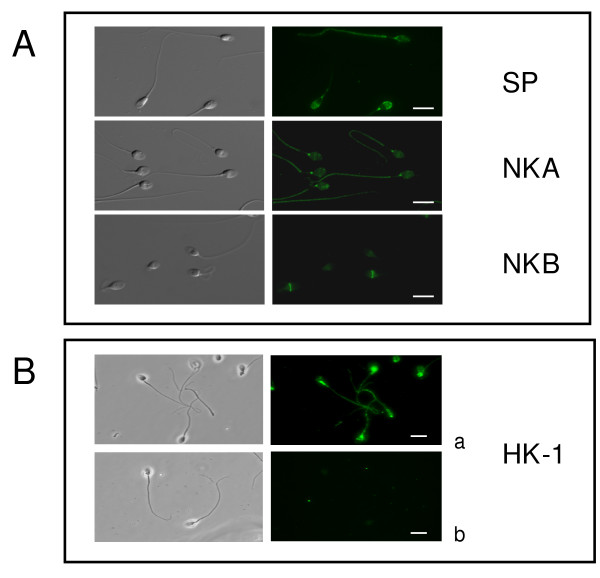
Immunofluorescent localization of tachykinins in human sperm. (A) Immunofluorescence and corresponding differential interference contrast images of sperm cells stained with primary antibodies against substance P (SP), neurokinin A (NKA) and neurokinin B (NKB) showing specific localizations for each peptide. (B) Immunofluorescence and corresponding phase contrast images of sperm cells stained with a primary antibody against hemokinin-1 (HK-1) in the absence (a) and in the presence (b) of immunogenic peptide. For each tachykinin, experiments were performed at least six times with similar results. Scale bar, 10 μM.